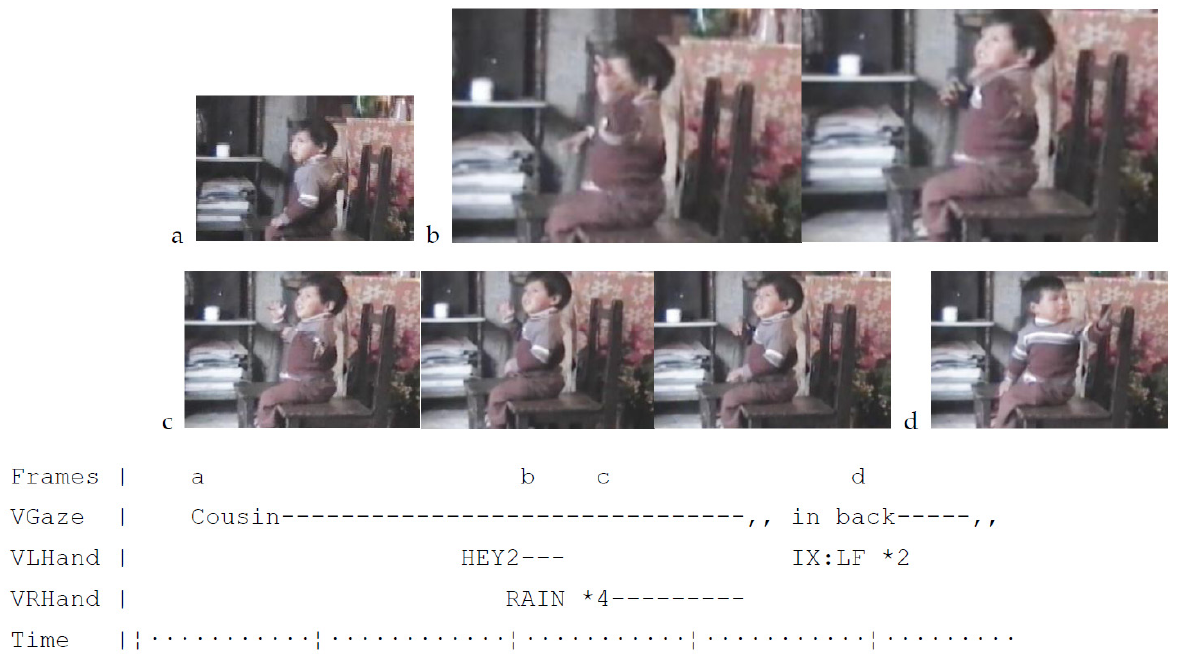
Figure 25. Vic at 28 mos. signed with both hands to comment on his cousin’s remarks about the rain. ( a ) Vic turned quickly to look outside, and then ( b ) he launched a HEY sign at her with his left hand. From his quick smile, one gathers that he had his cousin’s attention before he finished the quick hand flip, and even as he retracted his left hand to his shoulder, ( c ) he had begun signing HEAVY RAIN with his right hand. He repeated the sign several times, as he fully retracted his left hand, and then turned to point with his left hand at his mother on the other side of the room, ( d ) nodding as he signed for his cousin to tell her, too, that it was raining. Because of the limited camera view, it was again not possible to check when or whether Vic’s cousin saw and responded to his HEY sign, but he had already begun to prepare the RAIN sign with his right hand before he had finished the first request for attention with his left.